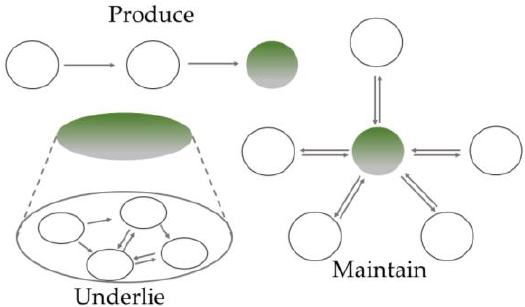
Figure 2. Three kinds of mechanisms; green circles depict the phenomenon to be explained (adapted from [3], p. 66) [3].